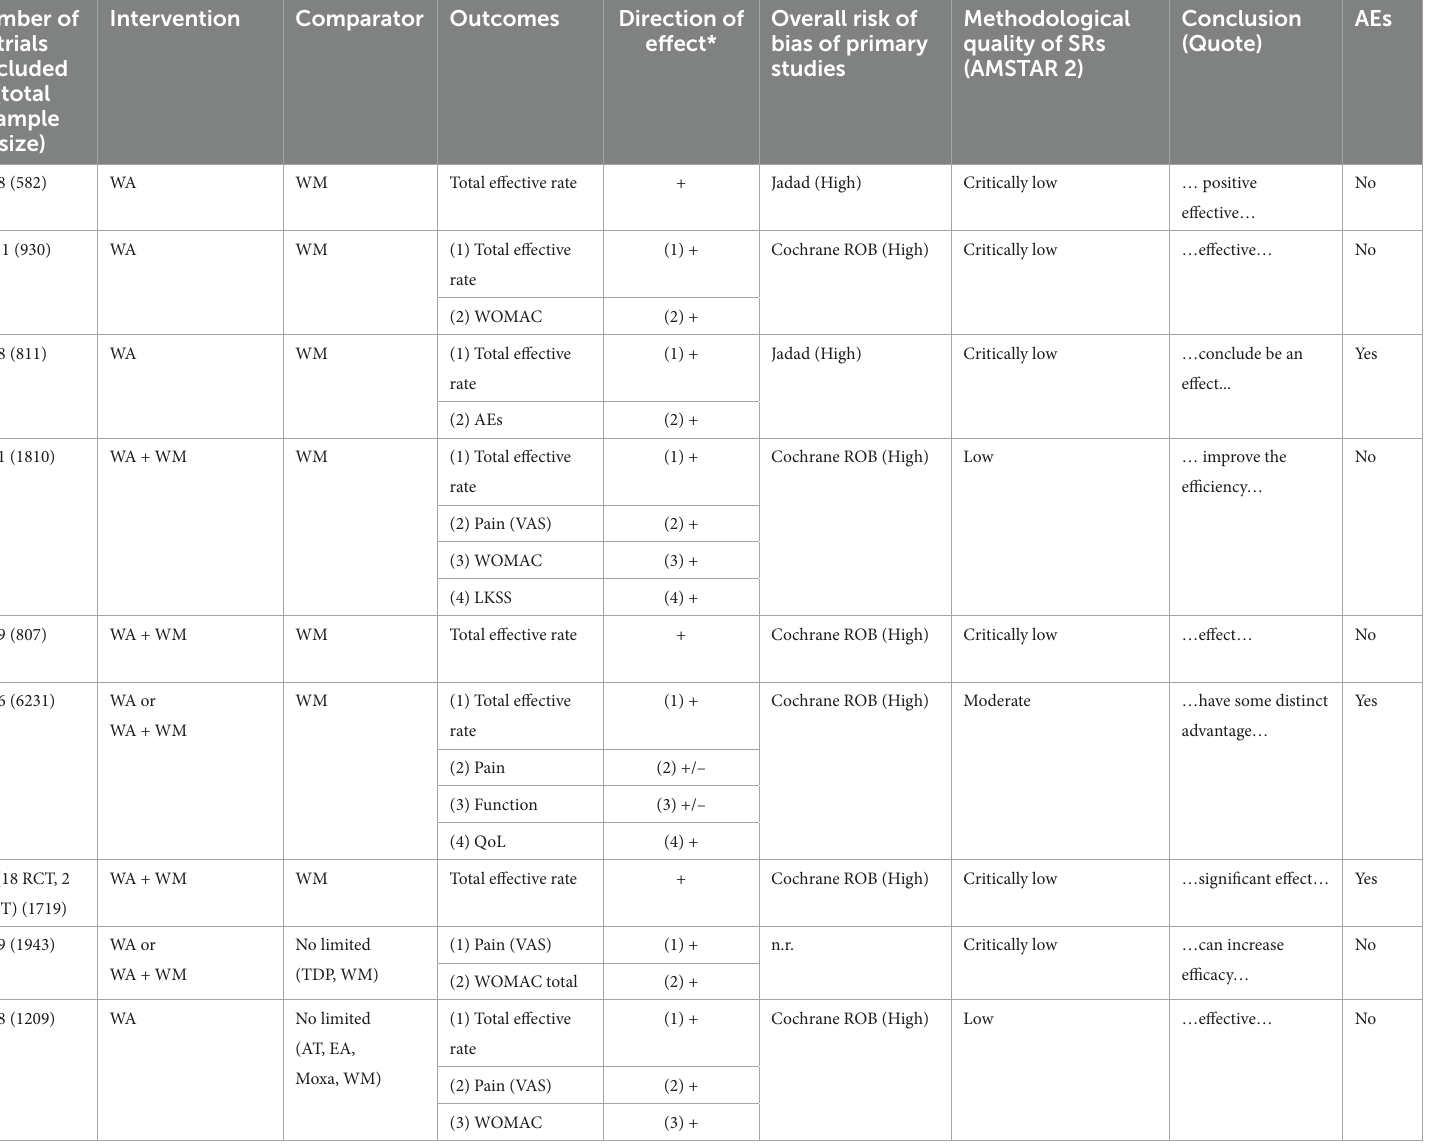
TABLE 1 Summary of systematic review studies of warm needle acupuncture for knee